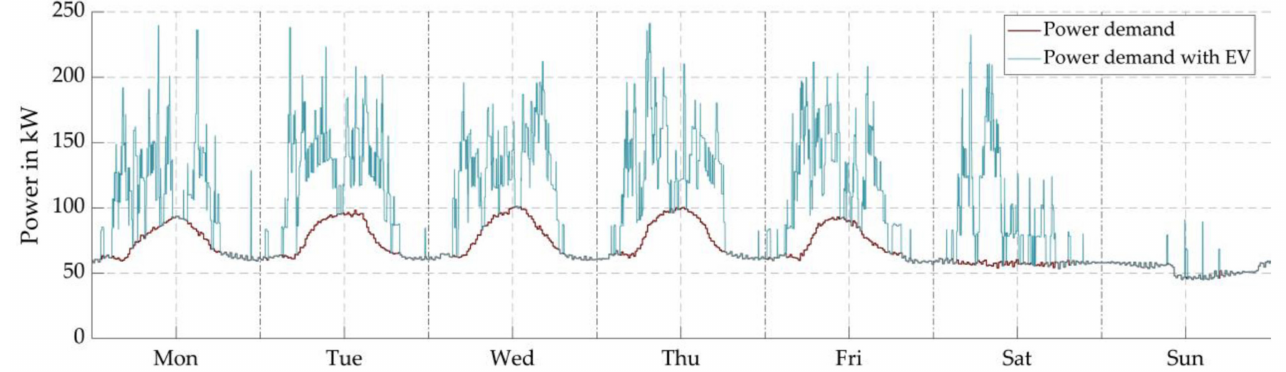
Figure 15. One week’s energy demand for the company including EVs.